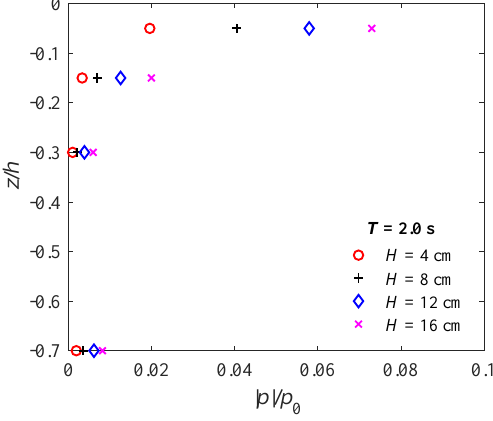
Figure 13. Distribution of the maximum pore-water pressures vs soil depth ( z / h ) behind the pile for various wave heights ( x = − 0.15 m, T = 2 s, Points 17, 18, 19, and